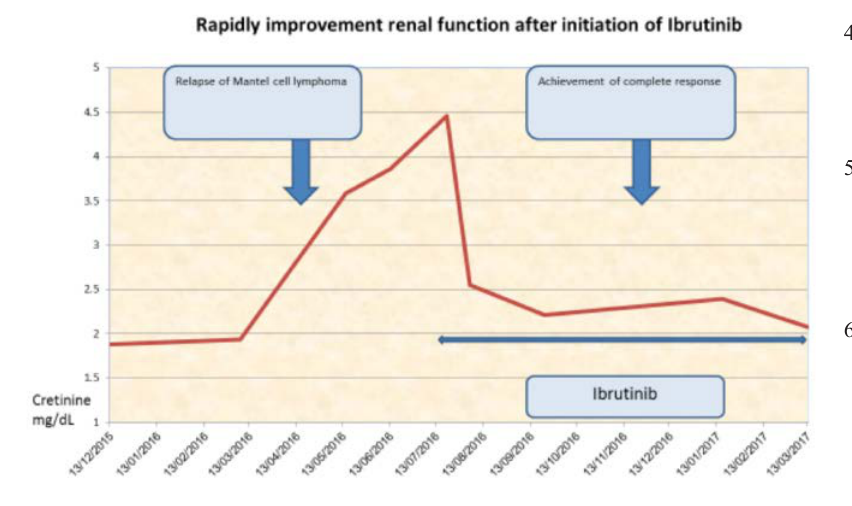
Figure 1. Rapidly improvement of renal function after the initiation of